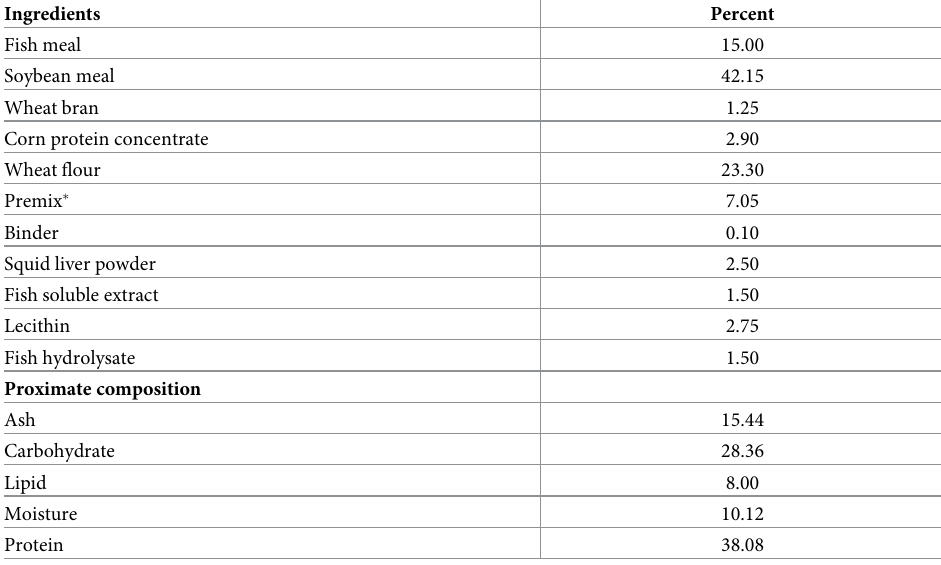
Table 1. Ingredients and proximate composition (%) of the basal diet used in the current study.